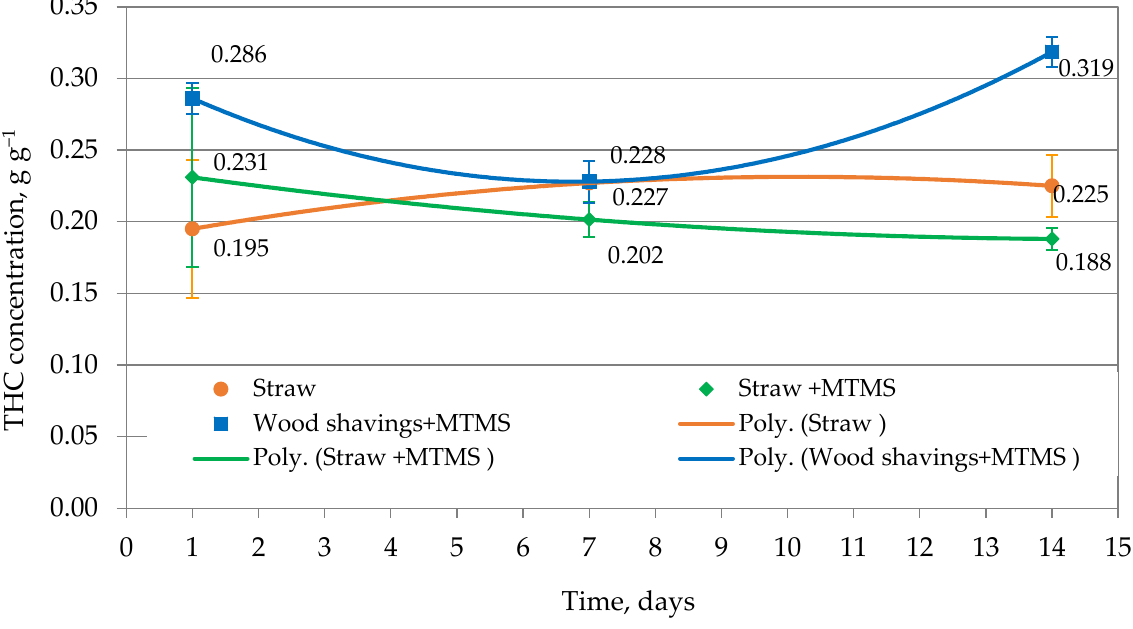
Figure 9. Dynamic of crude oil retention in sorbents. THC concentration of crude oil in the sorbent straw with and without MTMS treatment and MTMS-treated wood shavings after 1, 7 and 14 days. During the marine diesel oil sorption capacity investigation, the maximum of 0.319 g g −1 was observed for wood shavings + MTMS. In contrast, straw + MTMS demonstrated a minimum sorption capacity—0.188 g g −1 on the fourteenth day of the experiment (Figure 10).